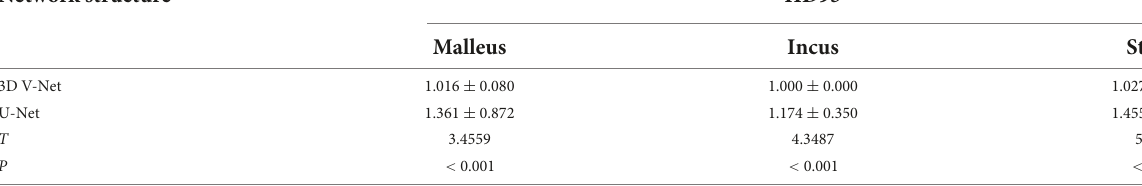
TABLE 5 Comparison of HD95 between automatic segmentation and manual segmentation under two neural networks. Network